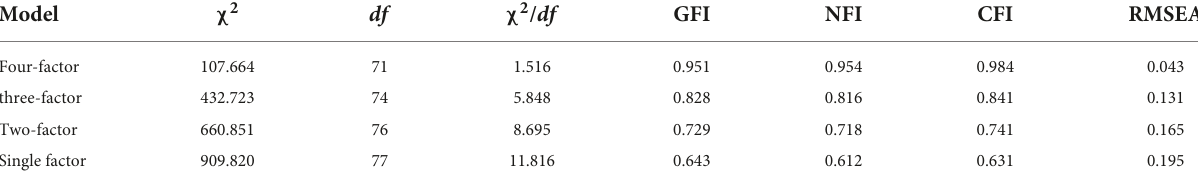
TABLE 3 Confirmatory factor analysis.